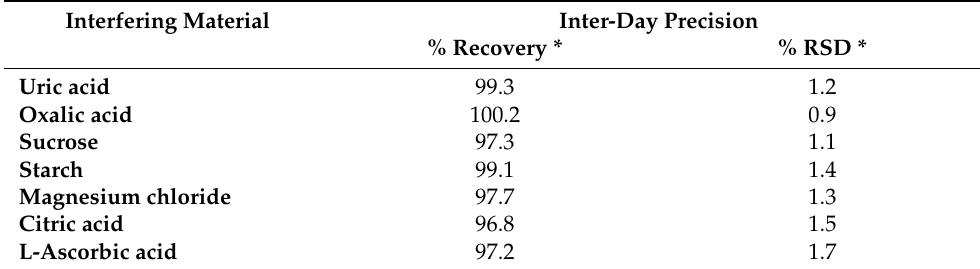
Table 3. Selectivity of the proposed SWV method for determination of